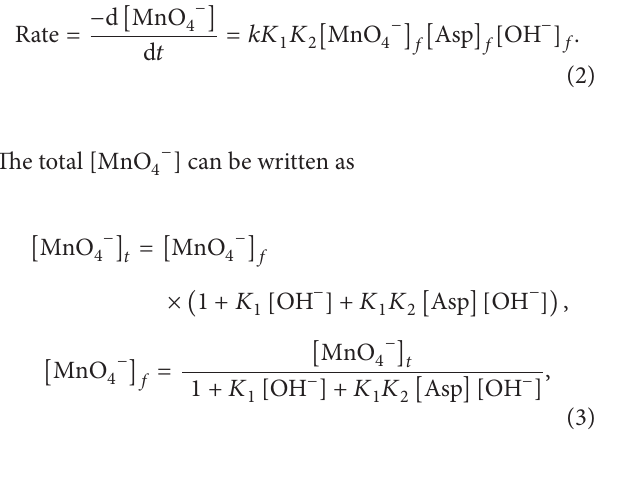
F 2: Spectral changes during the oxidation of  -Aspartic acid by permanganate in alkaline medium at 303K: 10 mixing; 2, 3, 4, 5, and 6 aer 5min, 10min, 15min, 20min, and 25min,